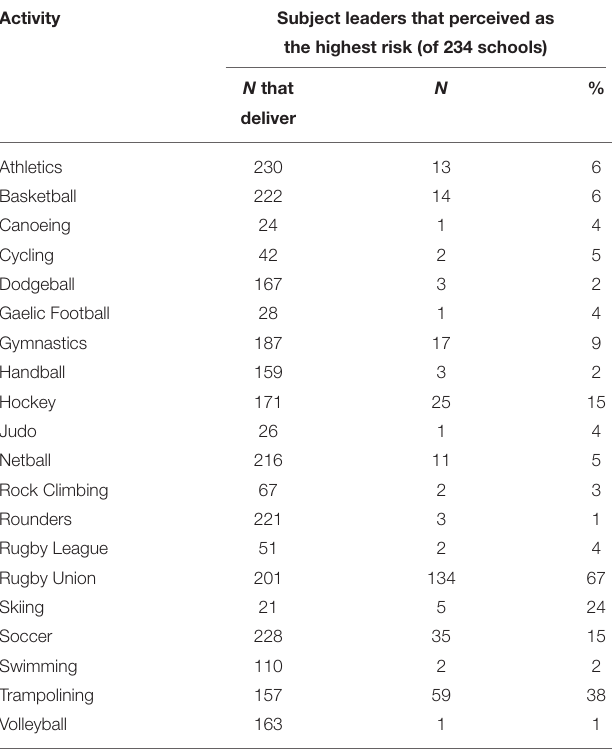
TABLE 2 | The number of subject leaders that perceived an activity to be the riskiest activity of the activities their school delivered.